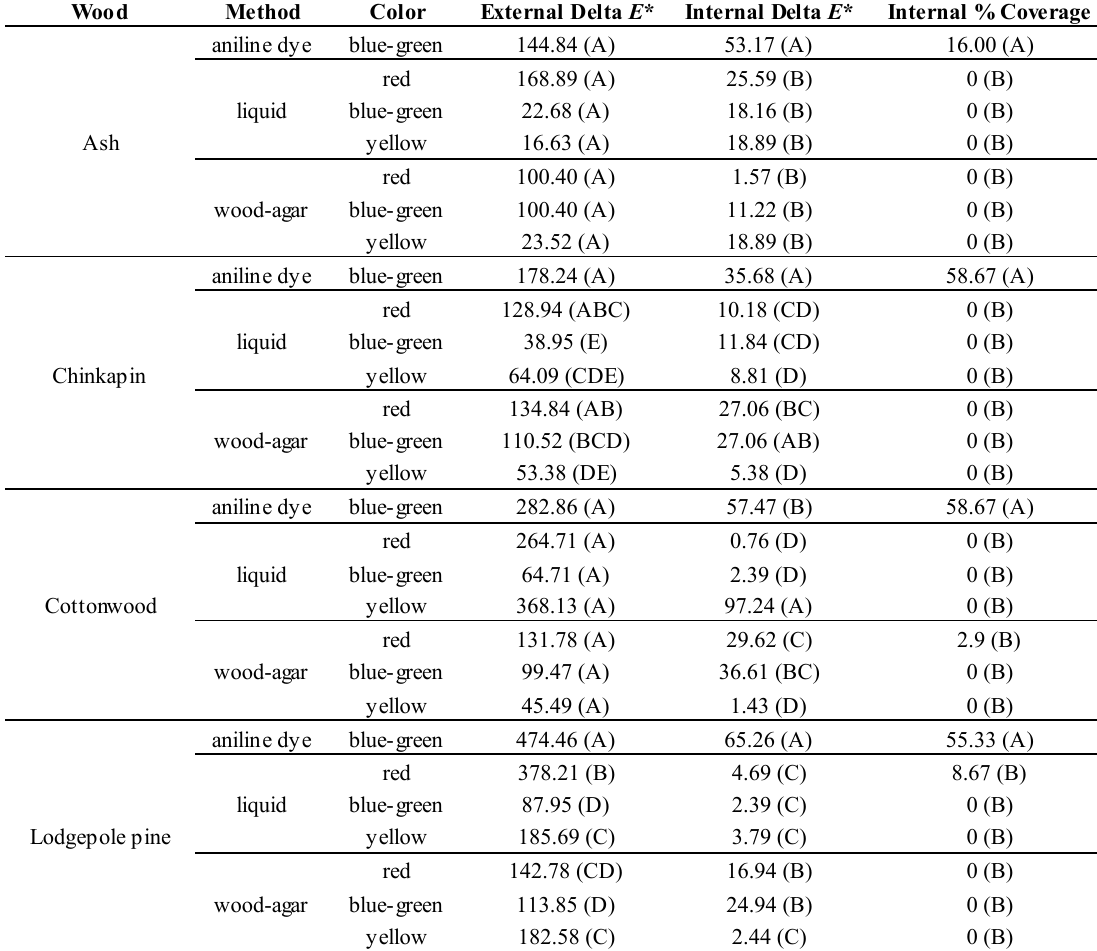
Table 1. ANOVA results for L * a * b * and percent coverage data by wood species. Different letters indicate statistically significant differences at alpha = 0.05 within each wood species and test